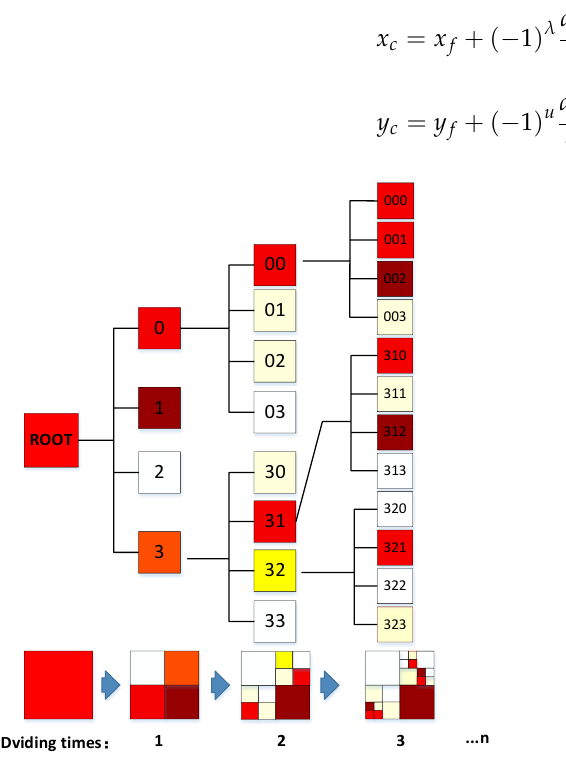
Figure 3. Unit grid-division process.